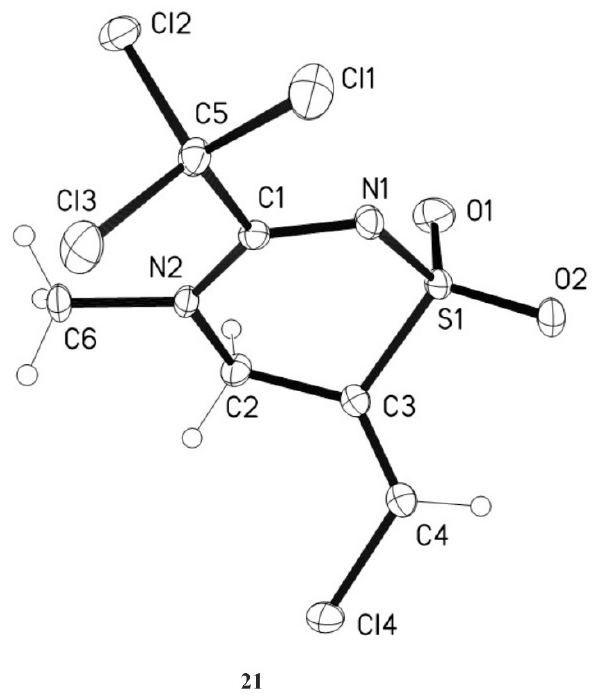
Figure 7. Molecular structure of ( E ) ‐ 6 ‐ chloromethylene ‐ 4 ‐ methyl ‐ 3 ‐ trichloromethyl ‐ 5,6 ‐ dihydro ‐ 4 H ‐ 1,2,4 ‐ thiadiazine ‐ 1,1 ‐ dioxide 21 including thermal displacement ellipses with 50% probability.